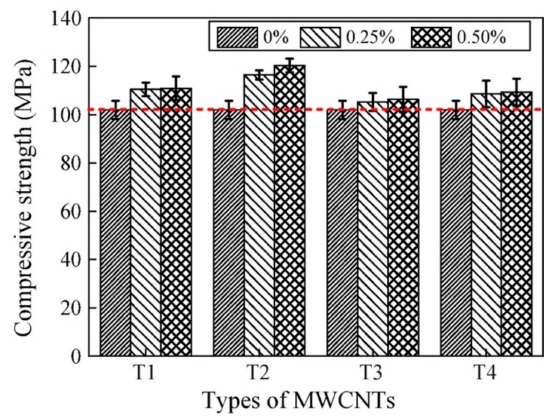
Figure 23. Compressive strengths of the MWCNTs reinforced RPC specimens under water curing. Reprinted with permission from [118]. Copyright © 2018, Elsevier B.V.